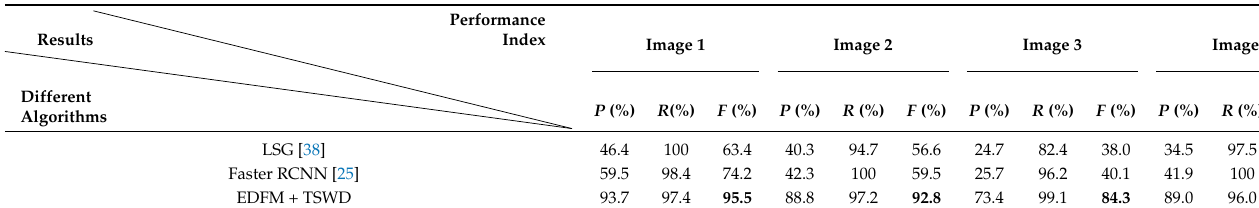
Table 4. Comparative results with state-of-the-art